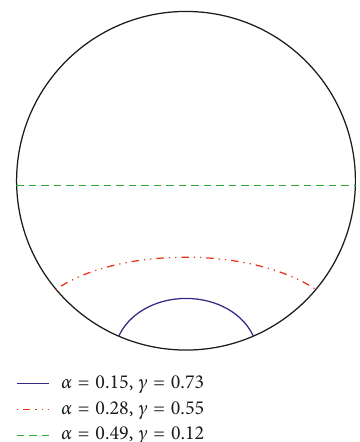
Figure 5: Considered cases in numerical